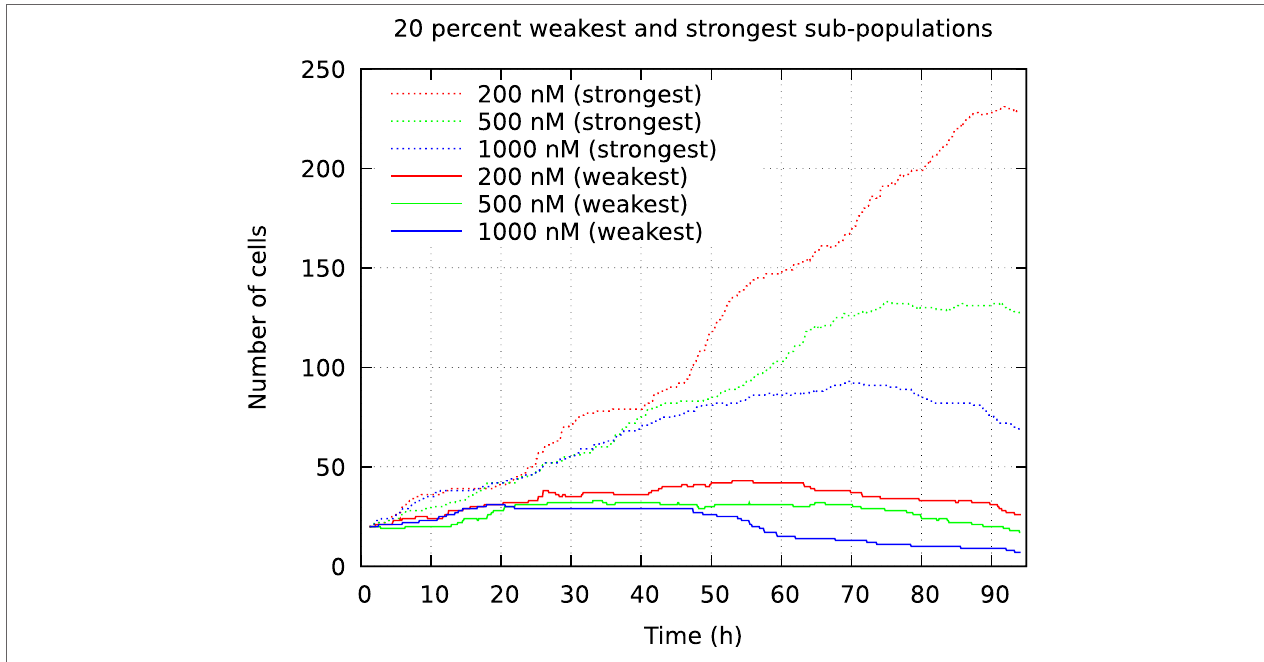
FigUre 10 | Development of number of cells from the 20% smallest and 20% largest pedigree trees in a cell population initially consisting of 100 individuals. The cells were exposed to YTX at concentrations 200, 500, and 1,000 nM. These data result from tracking the initial cells and their descendants.